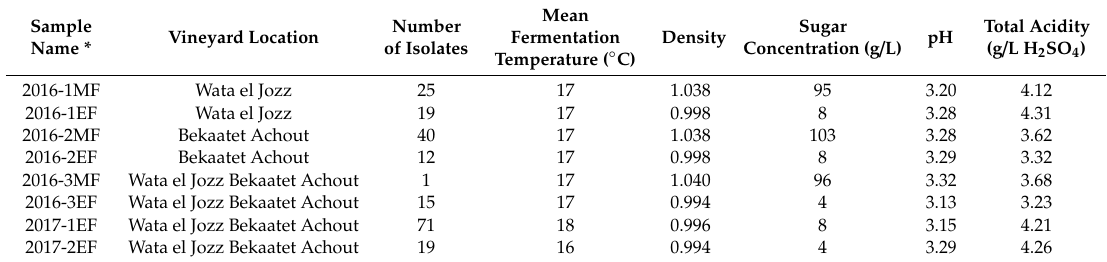
Table 3. Sample repartition and chemical analysis of the ‘Merwah’ samples collected at the middle and the end of the alcoholic fermentations over the two harvest seasons (2016,